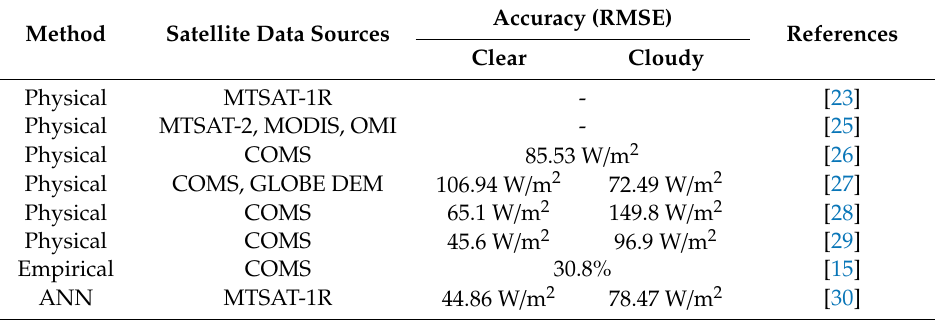
Table 1. Previous studies on solar irradiance estimation from satellite images, in Korea. RMSE: root mean square error; ANN: artificial neural network; MTSAT-1R: Multi-Functional Transport Satellite; OMI: Ozone Monitoring Instrument; COMS: Communication, Ocean and Meteorological